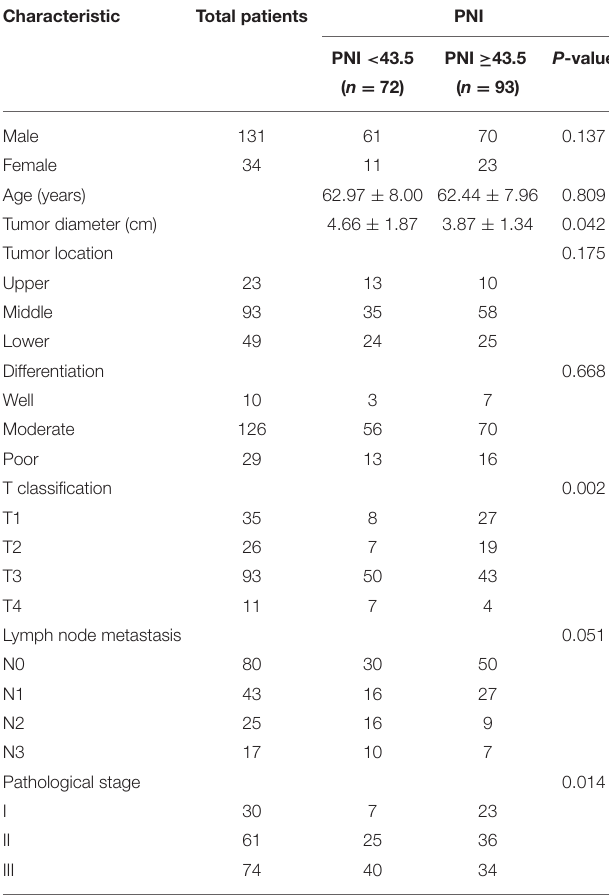
TABLE 1 | Relationships between prognostic nutritional index (PNI) and clinicopathological characteristics in 165 patients with esophageal squamous cell carcinoma